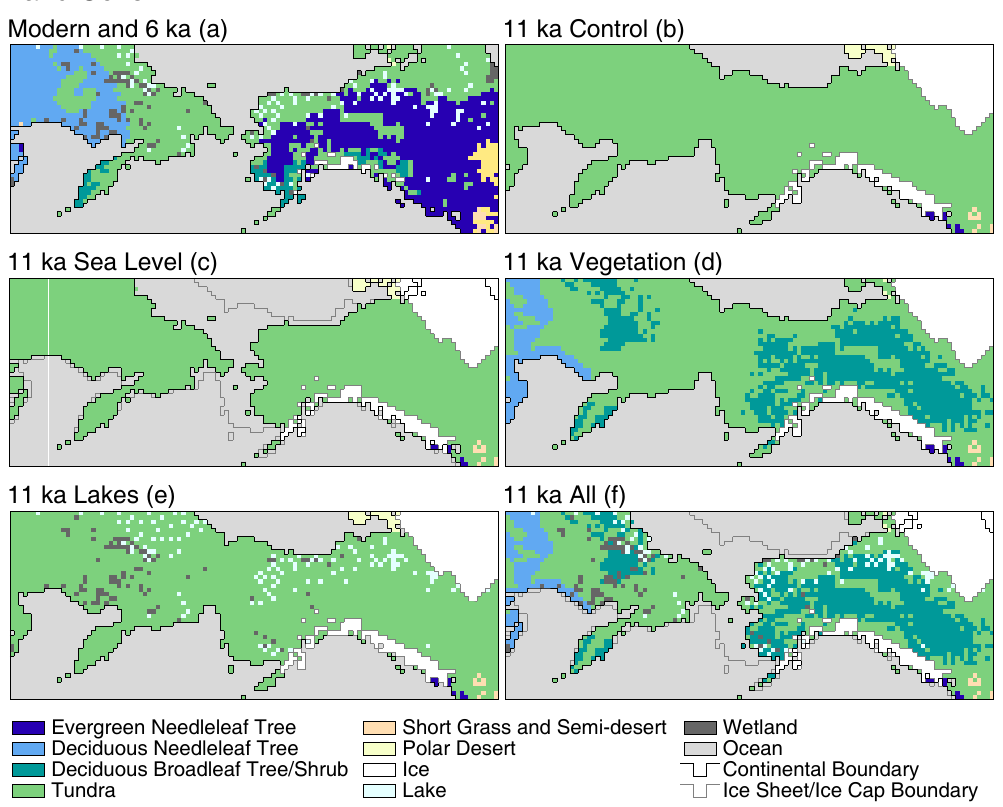
Figure 4. Land cover for RegCM climate simulations. Modern conditions are also used for the 6ka simulation; there are minor differences in forest cover between modern conditions and 6ka (see Fig. 3). The vegetation cover in each simulation is represented by the set of RegCM plant functional types (PFTs); the PFT Deciduous Broadleaf Tree/Shrub was created to represent the characteristics of short-statured deciduous woodland and tall-shrub communities. Land cover for 11ka All (f) combines all three experimental land-cover changes. Each land-cover map is linked to a RegCM simulation; an additional simulation was made using modern land cover with 11ka continental outlines (not